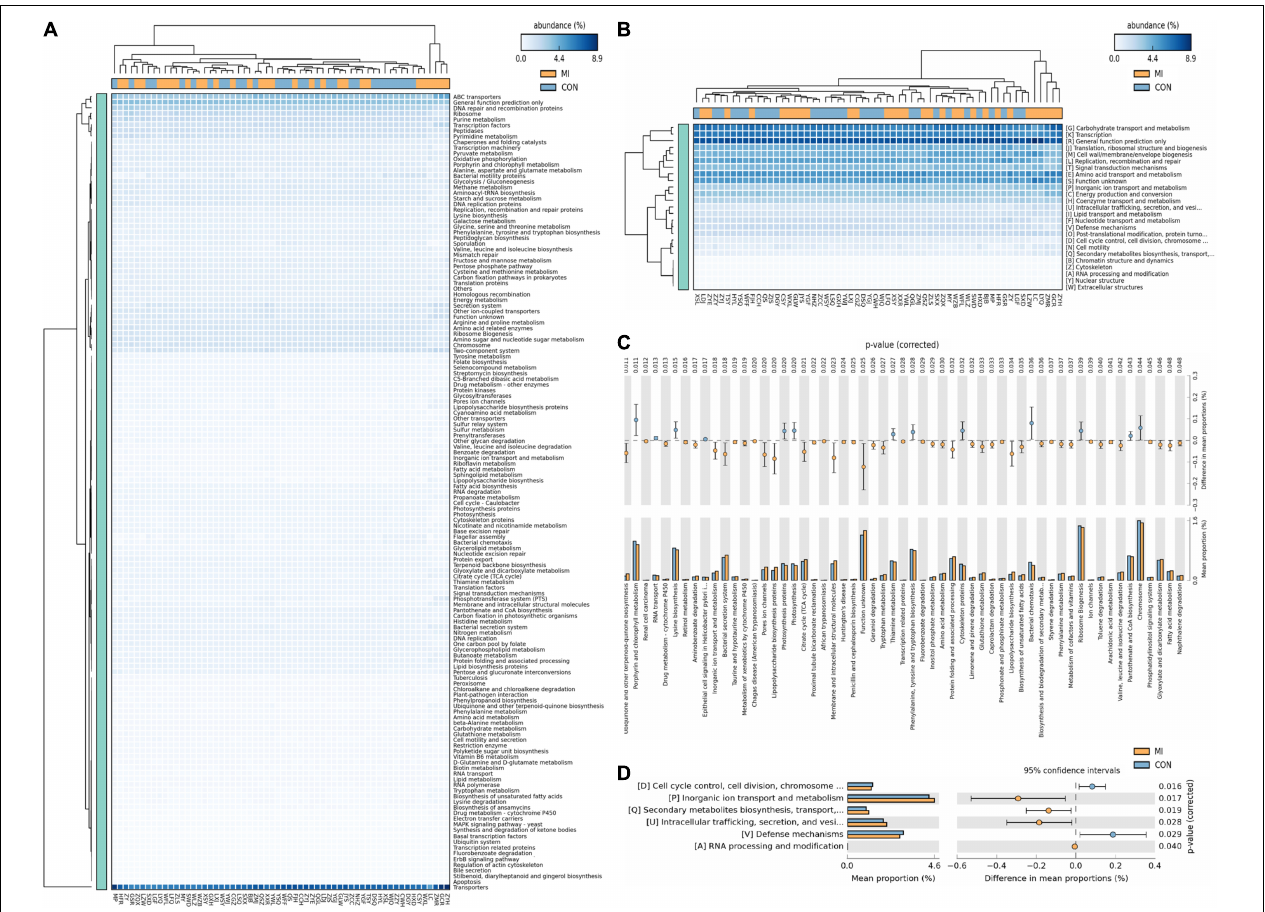
FIGURE 4 | The results of PICRUst based on closed-reference OTU to predict the abundances of functional categories COG orthologs (COs) and KEGG orthologs (KOs). Panels (A,C) shows the KOs with significantly different abundances in the fecal microbiome between the CHF group and healthy control group; (B,D) shows the COs with significantly different abundances in the fecal microbiome between the CHF group and healthy control group. HF, CHF group; CON, the healthy control group.